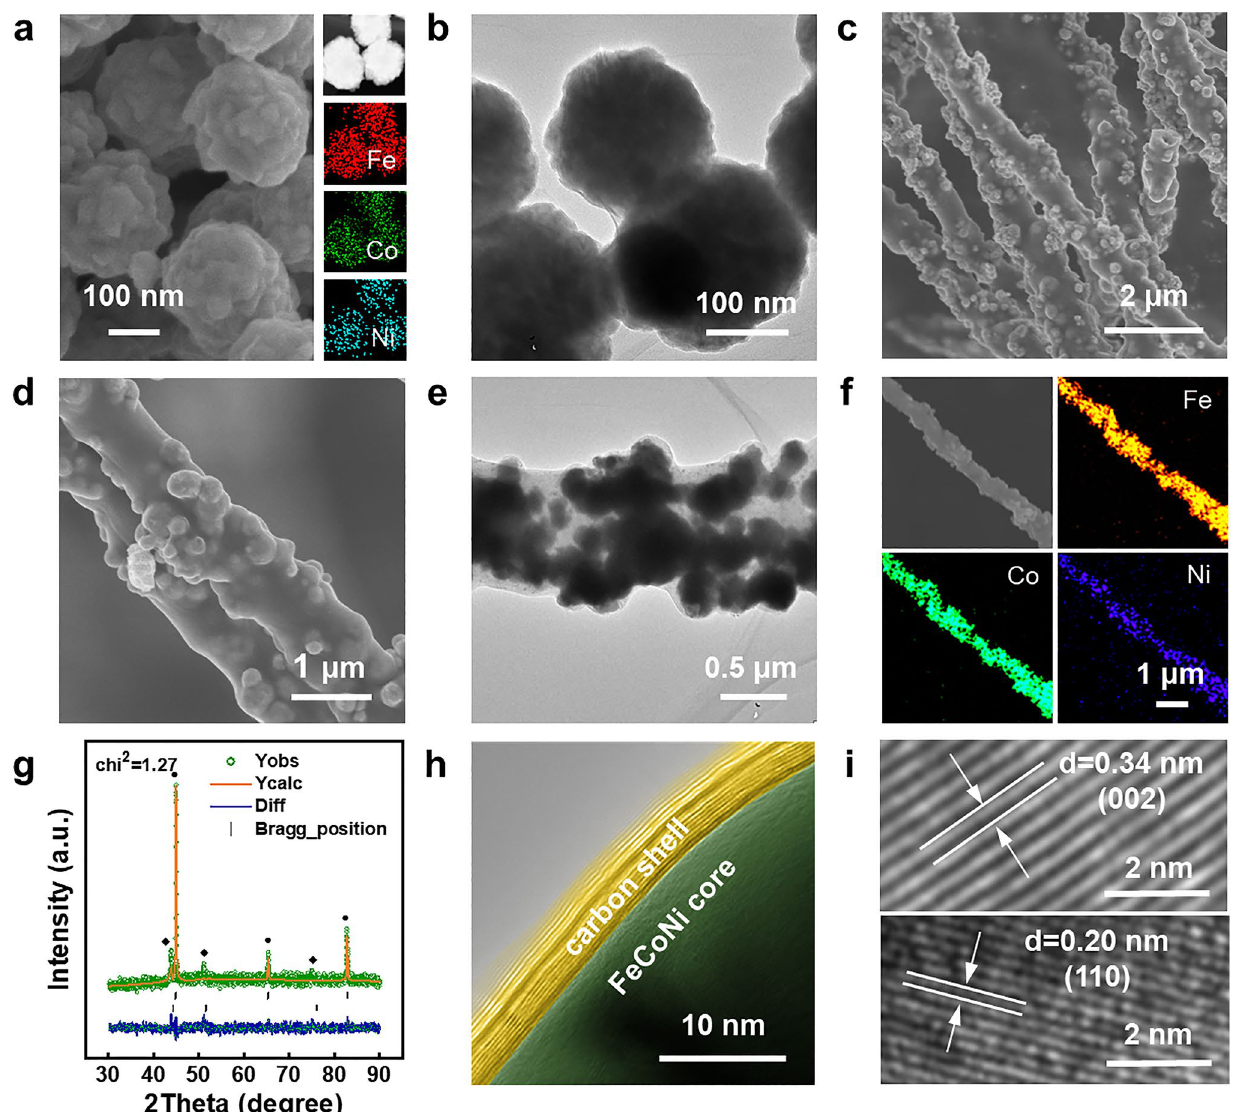
Fig. 2 a SEM, EDS mapping and b TEM images of FeCoNi NP. c , d SEM, e TEM, and f EDS mapping images of FeCoNi/CF-1. g XRD Riet- veld spectrum of the FeCoNi/CF-1. h , i HRTEM images of